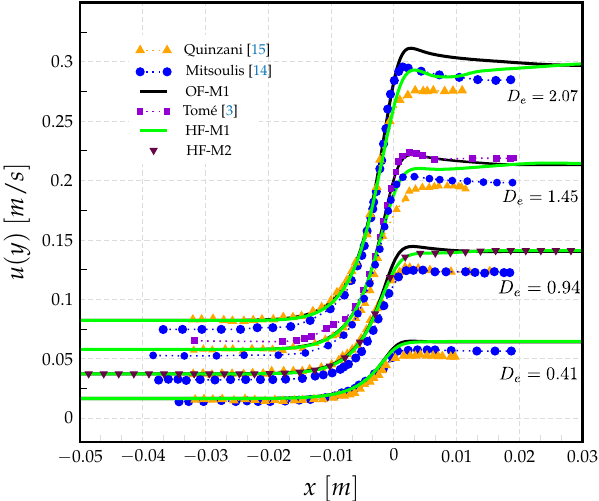
Figure 10. Centerline axial velocity profiles obtained using HiGFlow (green lines) and OpenFOAM (black lines). Experimental [15] and numerical results [3,14] found in the literature are also shown for comparison